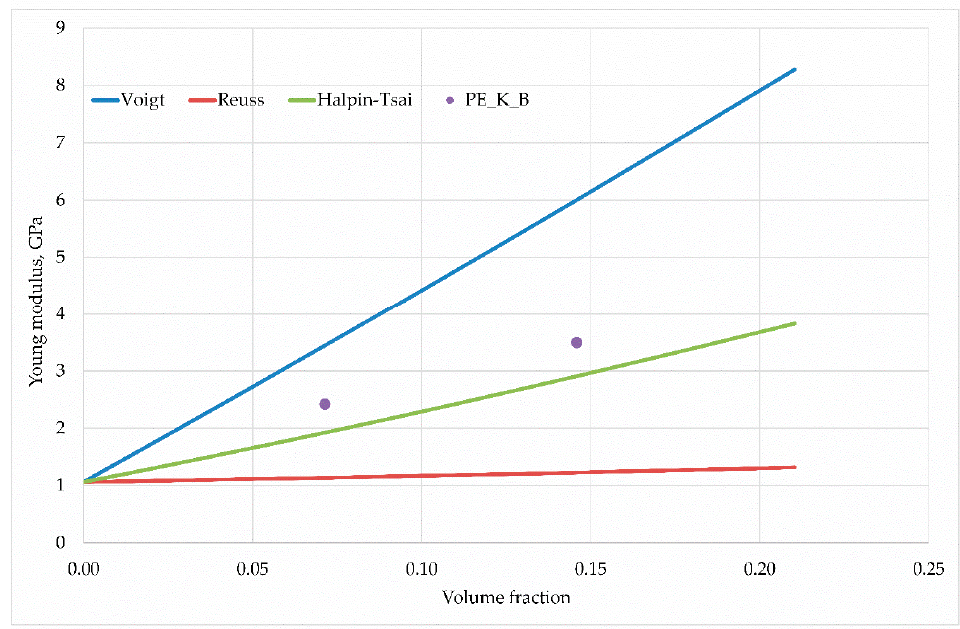
Figure 13. Young’s modulus dependence on the coconut fiber and basalt fiber content in the PE Figure 13. Young ’ s modulus dependence on the coconut fiber and basalt fiber content in the PE matrix.